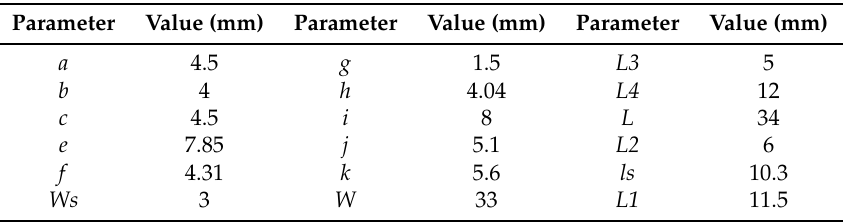
Table 1. Different parameters and values of the antenna.